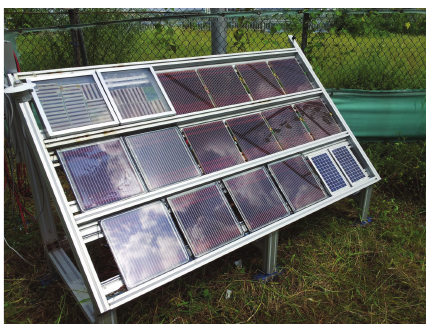
Figure 9: Outdoor testing facility.